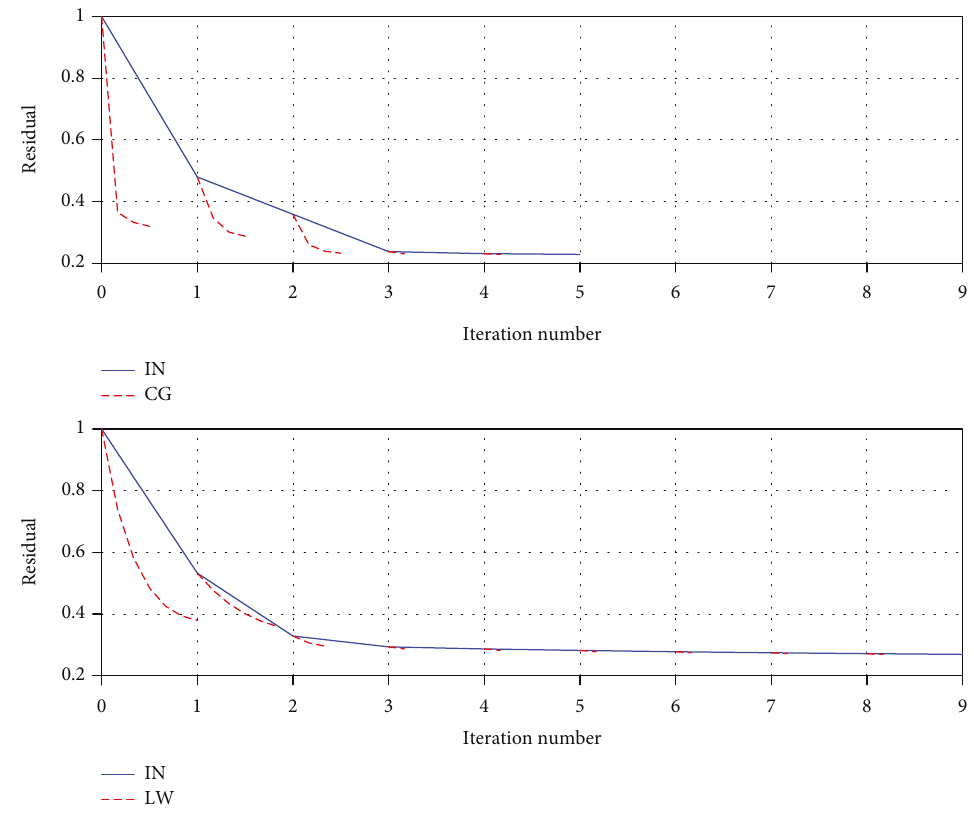
Figure 6: Behaviour of the normalized data residuals for the conjugate gradient-based (top, p = 1 3 ) methods versus the iteration number. Residuals in the outer inexact Newton (IN) iterations and in the inner conjugate gradient p opt (CG) and Landweber (LW) loops are reported. Single dielectric sphere with a